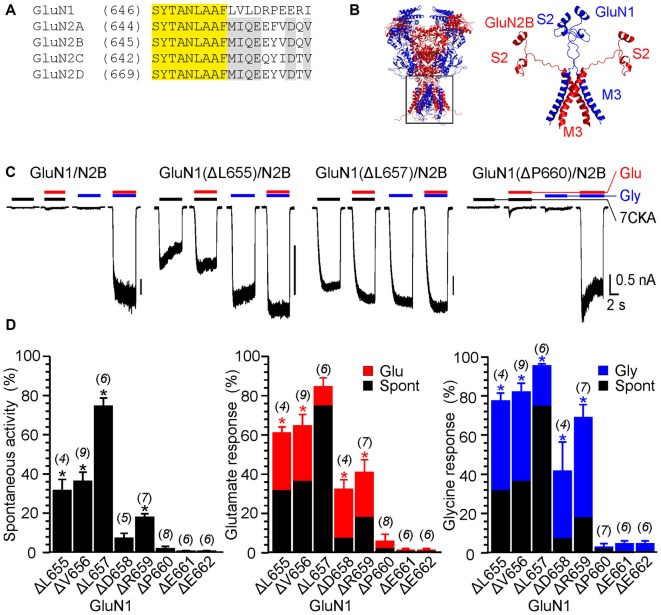
The effect of single-deletion mutations of GluN1 linker on receptor activity. (A) Amino acids (AA) sequence alignment for the outer segment of the pore-forming region of the M3 and the initial segment of the M3-S2 linker. AA number is given in parentheses. Conserved motifs in N-methyl-D-aspartate (NMDA) receptor subunits are colored yellow (GluN1/GluN2) and gray (GluN2A-D). (B) Homology model of GluN1/GluN2B and the structure of the M3 and M3-S2 linkers are shown. GluN1 is colored in blue and GluN2B is colored in red. Note the different orientation of the M3-S2 linkers in GluN1 and GluN2B. (C) Representative current responses of GluN1/GluN2B wild-type (WT), GluN1(ΔL655)/GluN2B, GluN1(ΔL657)/GluN2B and GluN1(ΔP660)/GluN2B. Application of extracellular solution (ECS) containing 7-Chlorokynurenic acid (7CKA; 10 μM) with no added Mg2+, glutamate, or glycine is indicated by a black bar (7CKA); application of 1 mM glutamate and 7CKA (10 μM) with no added Mg2+ or glycine is indicated by a red bar (Glu); application of 0.1 mM glycine with no added Mg2+ or glutamate is indicated by a blue bar (Gly). In between the applications of Mg2+-free ECS, the cells were bathed in ECS containing 2 mM Mg2+. (D) Summary graphs of the mean ± SEM (n) of the relative responses—RISpont (black columns), RIGlu (red columns) and RIGly (blue columns; see Equations 1–3)—in receptors with a single residue deleted in GluN1. Differences in the relative responses determined for WT and mutated receptors were statistically significant; one-way ANOVA (P < 0.001); followed by multiple comparisons of the relative responses of mutated receptors vs. WT (RISpont 0.44 ± 0.06 (n = 24); RIGlu 0.63 ± 0.30 (n = 24); RIGly 1.1 ± 0.2 (n = 24)); Dunnett’s test; *P < 0.050.